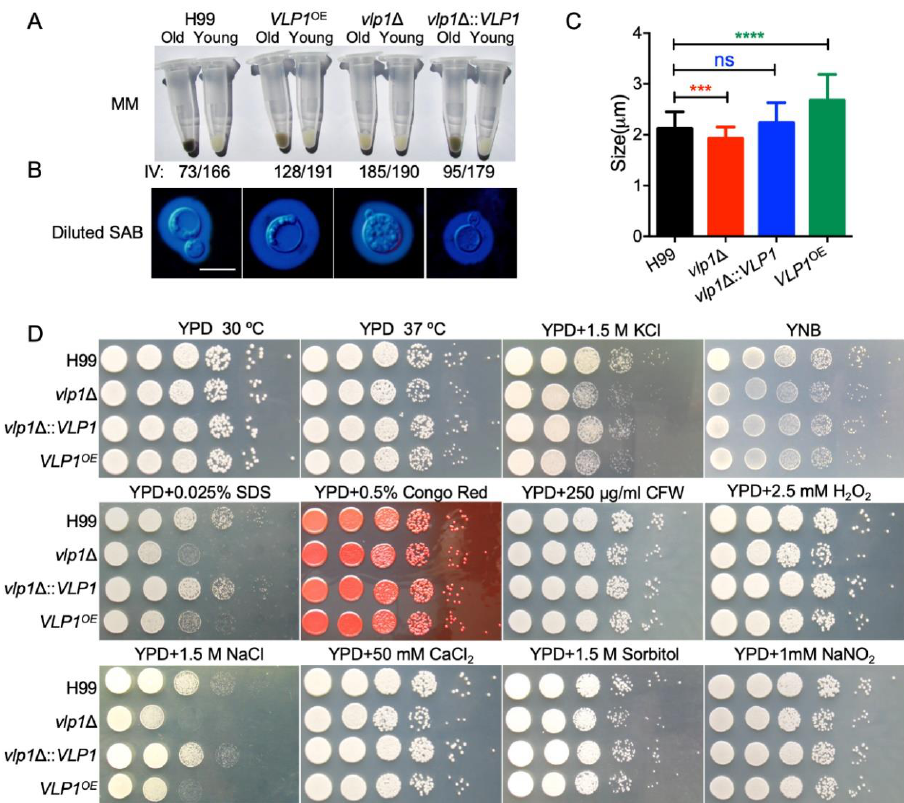
Figure 2. Disruption of VLP1 affects the capsule formation, melanin production, and growth under stress conditions in C. neoformans . ( A ) Melanin production of each Cryptococcus strain was induced in melanization media. Cell pellets (top) of the old or young cells were imaged, and the darkness (bottom) of the cells was quantified using black to white histogram analysis. ( B ) Capsule formation of each Cryptococcus strain was examined using India ink staining under a microscope after overnight culture (~18 h) in diluted Sabouraud medium. SAB: Sabouraud medium; bar, 10 µm. ( C ) Statistical analysis of the capsule formation in diluted Sabouraud medium. At least 100 cells were measured for each Cryptococcus strain, and the data are shown as the mean ±SD from three repeats. ns: not significant; ***, p < 0.001; ****, p < 0.0001. ( D ) Growth of each Cryptococcus strain under different stress conditions. Overnight culture of each Cryptococcus strain was first adjusted to OD600 value of 2.0 and then 10-fold serially diluted with ddH 2 O. An amount of 5 µL of each dilution was dropped onto the YPD plates with different stresses and then incubated at 30 °C for 2 or 3 days. The names of the Cryptococcus strains are labeled on the left, and the culture conditions are shown on the top.